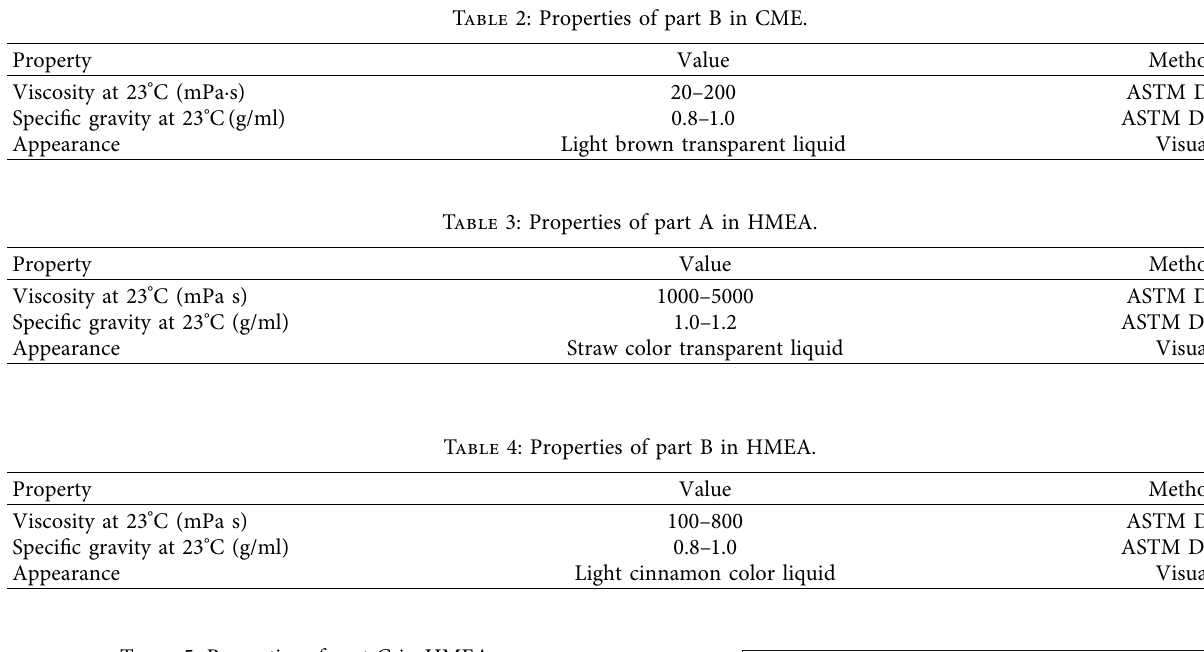
Table 5: Properties of part C in HMEA.